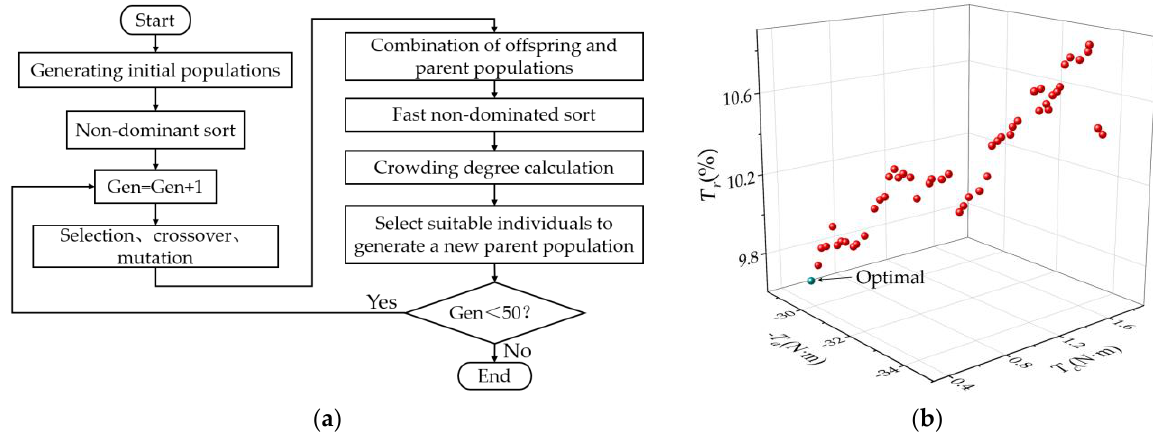
Figure 4. NSGA-II: ( a ) flow chart of NSGA-II; ( b ) Pareto solution set.